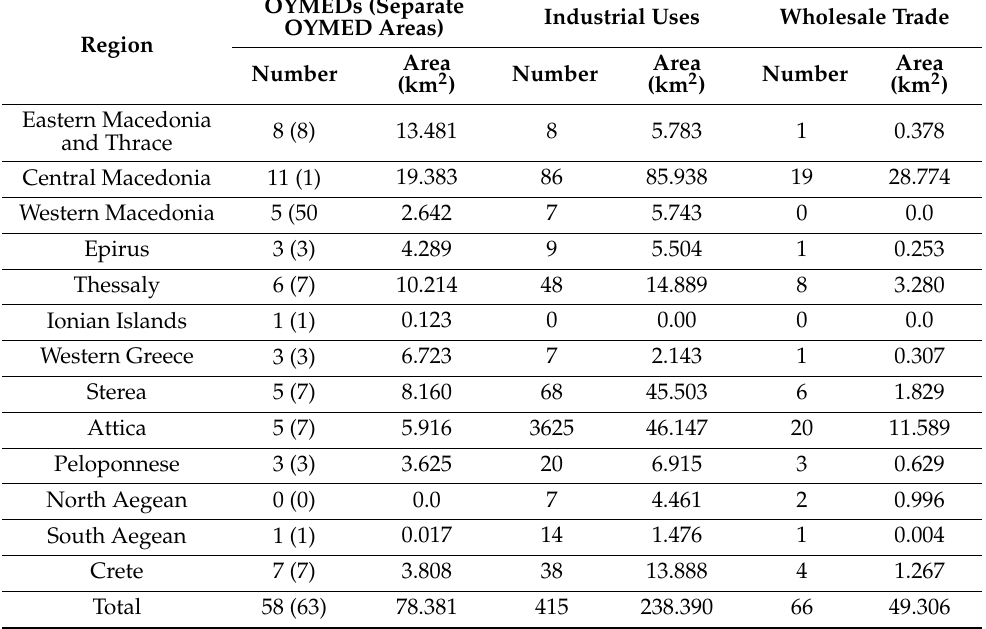
Table 2. Spatial allocation and characteristics of Organized Receptors of Manufacturing and Business Activities (OYMEDs) in the Greek